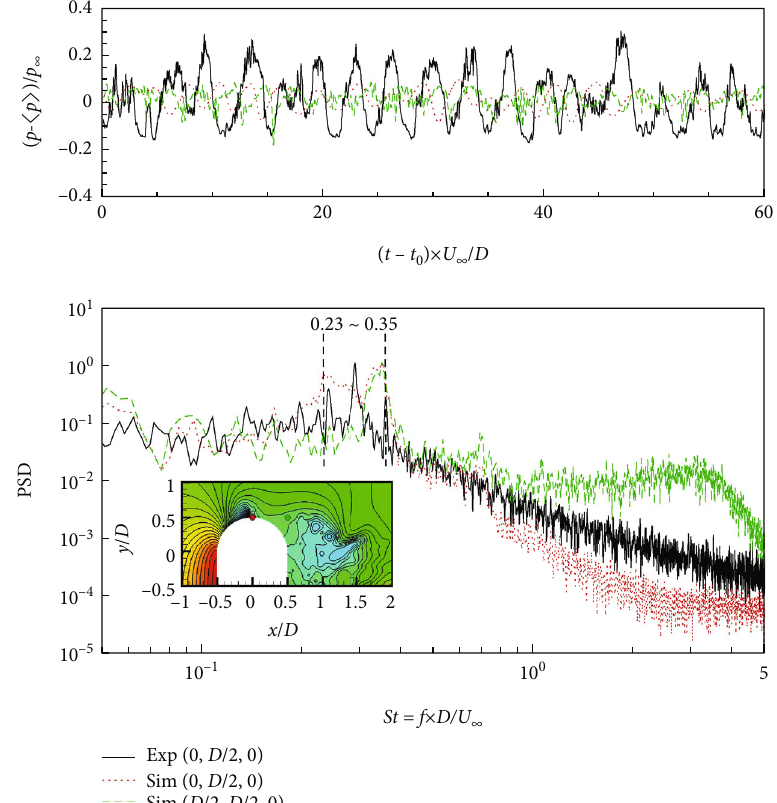
Figure 13: Transient pressures and their power spectral density (PSD), where the solid black line represents ð 0, D /2, 0 Þ for experiment, and the red dotted line and green dotted line represent ð 0, D /2, 0 Þ and ð 0, D /2, D /2 Þ for